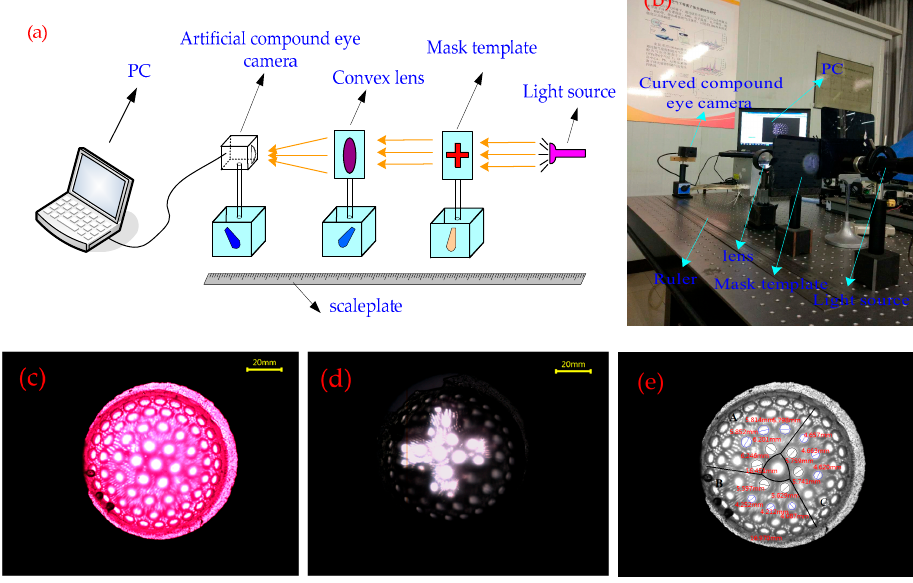
Figure 8. Zoom surface compound eye imaging experiment system and imaging analysis: ( a ) compound eye imaging experimental schematic; ( b ) photograph of the experiment setup; ( c ) curved compound eye collection on circular spot image; ( d ) curved compound eye collection on cruciform spot image; ( e ) sub-eye image size levels.